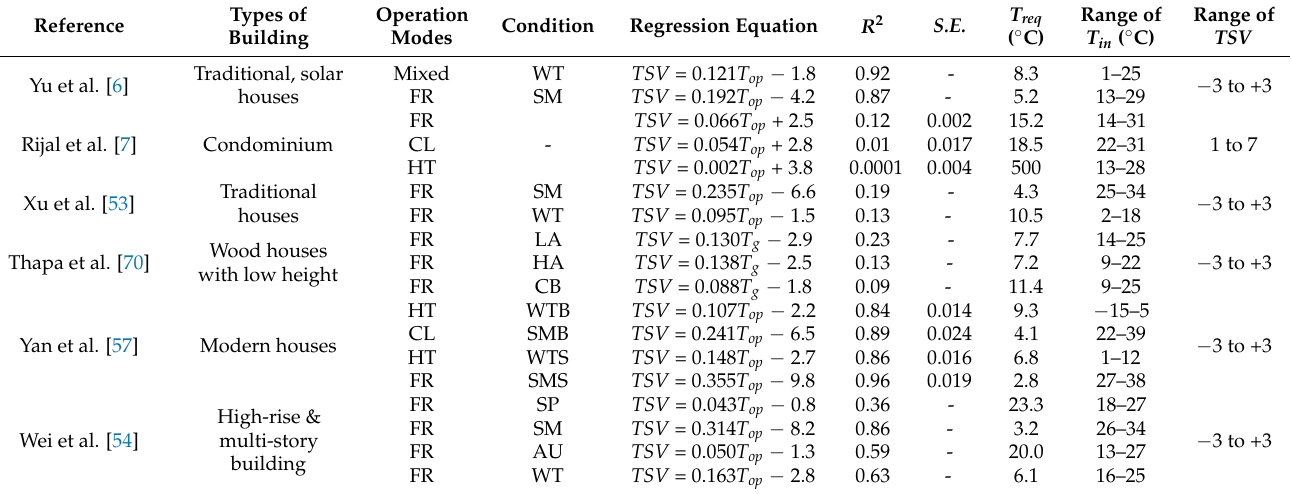
Table 2. Regression equations of TSV and indoor air temperature from previous